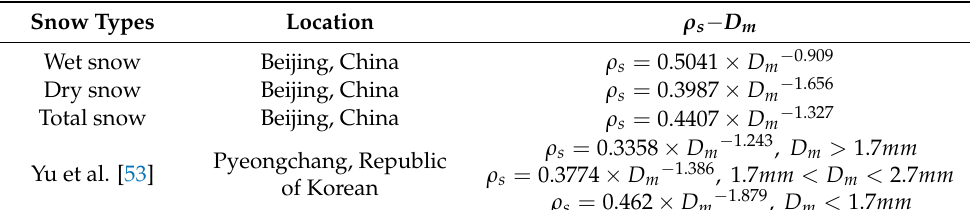
Table 5. The relationship of 𝑍 (cid:3032) − 𝑆𝑅 for snow.